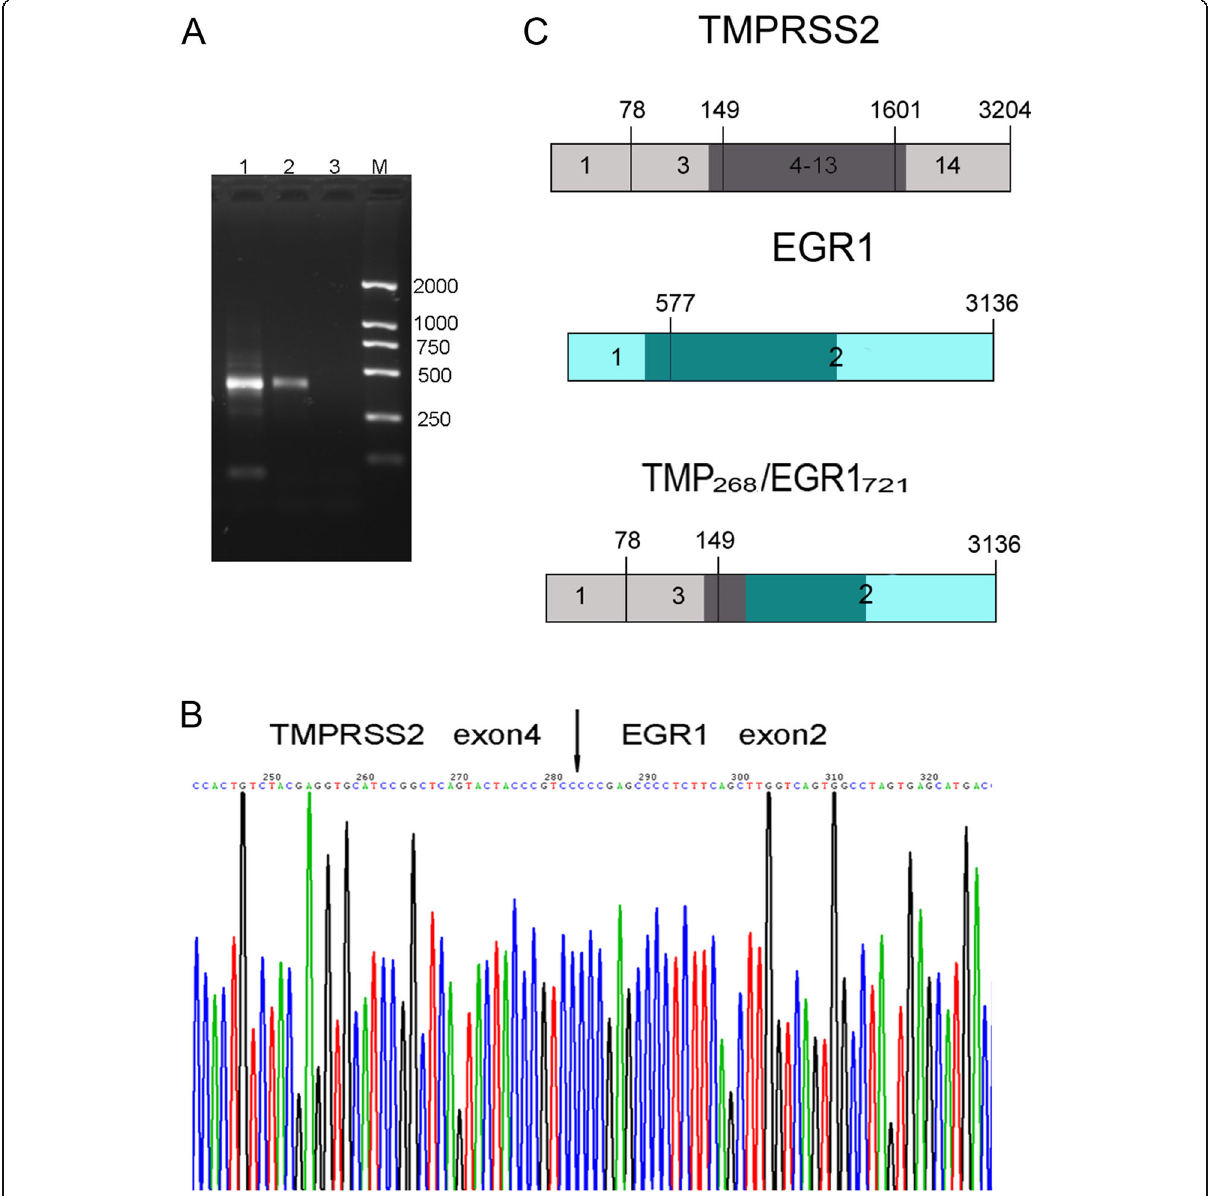
Fig. 2 Expression of TMPRSS2: EGR1 fusion gene in needle biopsy samples of PCa patient no. 19. a Detection TMPRSS2: EGR1 gene fusion by nest PCR. M, molecular mark; lane 1, the TMPRSS2: EGR1 T/A clone vector; lane 2, no. 19 sample cDNA; lane 3, ddH2O as negative control. b TMPR SS2:EGR1 hybrid transcript was identified by sequencing. Position no. 268 of TMPRSS2 exon 4 was fused to position no. 721 of EGR1 exon 2. c The schematic structure of TMPRSS2(NM_005656.3), EGR1 (NM_001964.2), and their hybrid mRNAs. The coding region was shown in deep